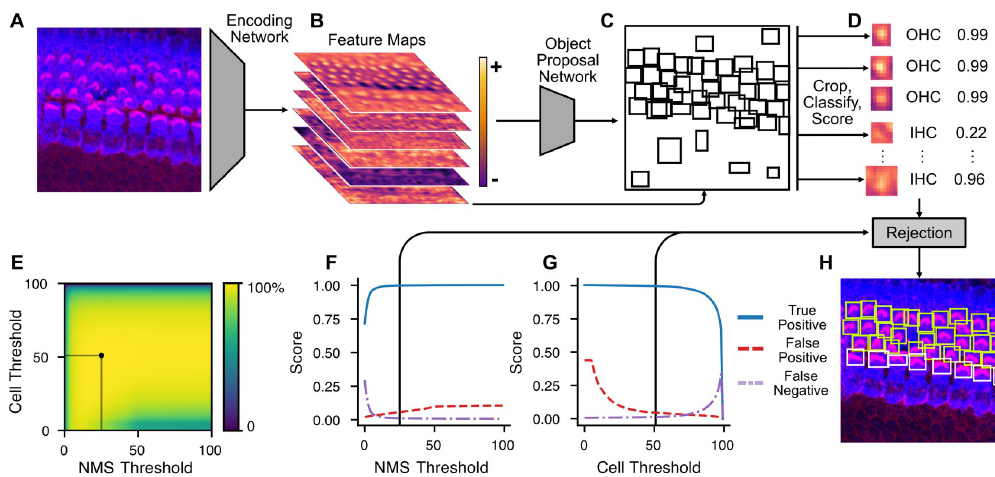
Fig 3. Schematized overview of Faster R-CNN image detection backend. ( A ) Input micrographs (in this case, of early postnatal mouse hair cells) are encoded into high-level representations (schematized in ( B )) by a trained encoding convolutional neural network. These high-level representations are next passed to a region proposal network that predicts bounding boxes of objects (( C ), schematized representation). Based on the predicted object proposals, encoded crops are classified into OHC and IHC classes by the neural network and assigned a confidence score ( D ). Next, a rejection step thresholds the resulting predictions based on confidence scores and the overlap between boxes, via NMS. Default values for user-definable thresholds were determined by the maximum average precision after a grid search of parameter combinations over eight manually annotated cochleae ( E ). The outcome of this grid search can be flattened into accuracy curves for the NMS ( F ) and rejection threshold ( G ) at their respective maxima. Boxes remaining after rejection represent the models’ best estimate of each detected object in the image ( H ). IHC, inner hair cell; NMS, non-maximum suppression; OHC, outer hair